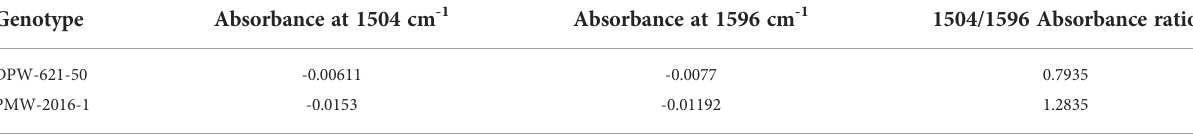
TABLE 3 Comparison of lignin absorbance from the FTIR spectra of the two different genotypes of wheat stem cell walls illustrating the maximum lignin content in PMW-2016-1.